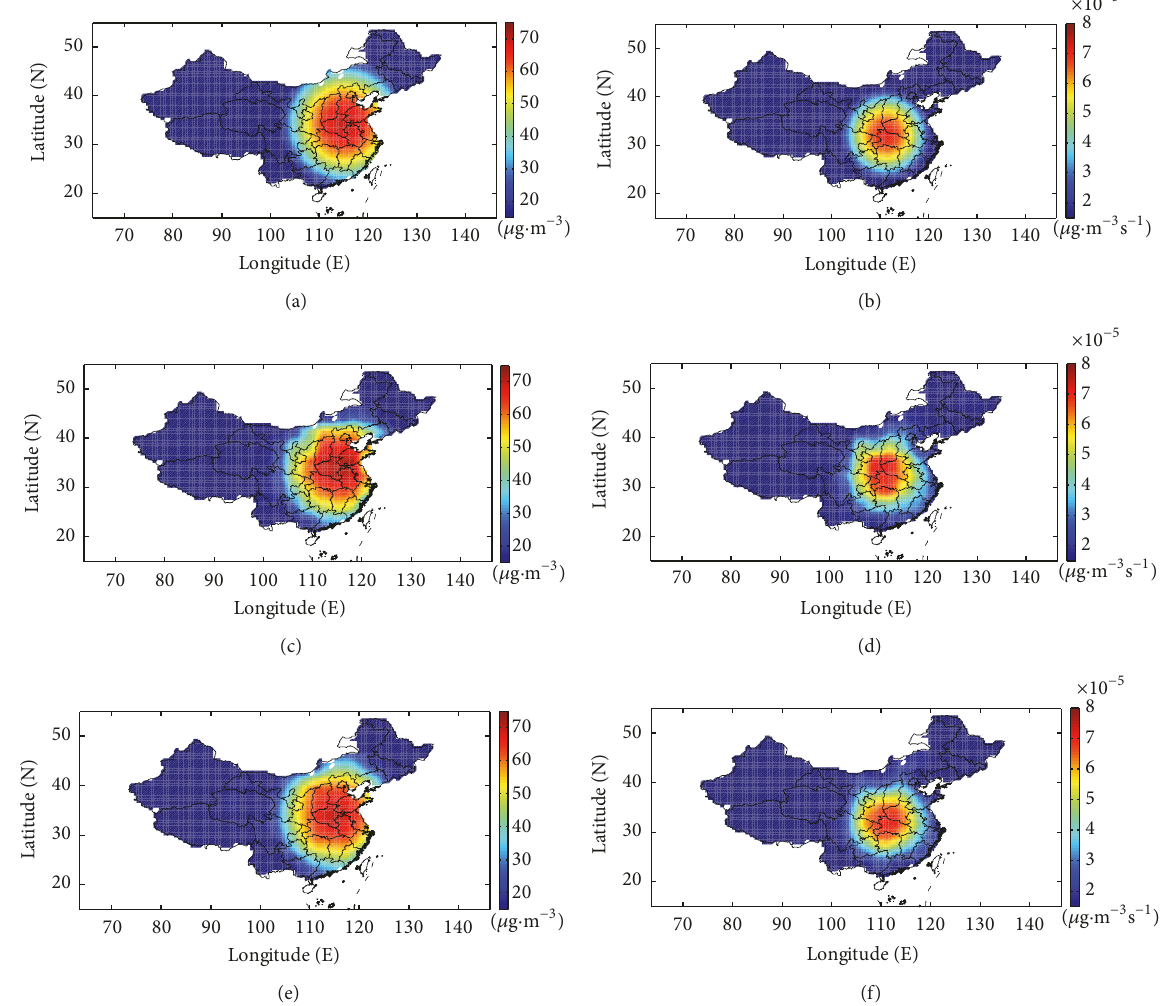
Figure 4: (a) The prescribed IC, (b) the prescribed SS, (c) the inverted IC obtained from Cressman interpolation, (d) the inverted SS obtained from Cressman interpolation, (e) the inverted IC obtained from PPM (4) , and (f) the inverted SS obtained from PPM (4)